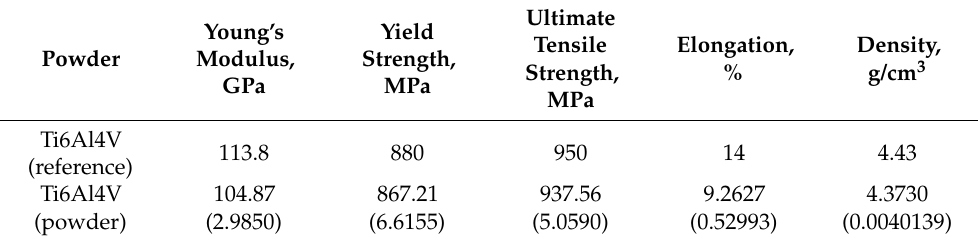
Figure 2. Stress-strain curves the additively manufactured structures using Ti6Al4V. Table 2. Tensile properties of AM-based structures with Ti6Al4V. Table 2. Tensile properties of AM-based structures with